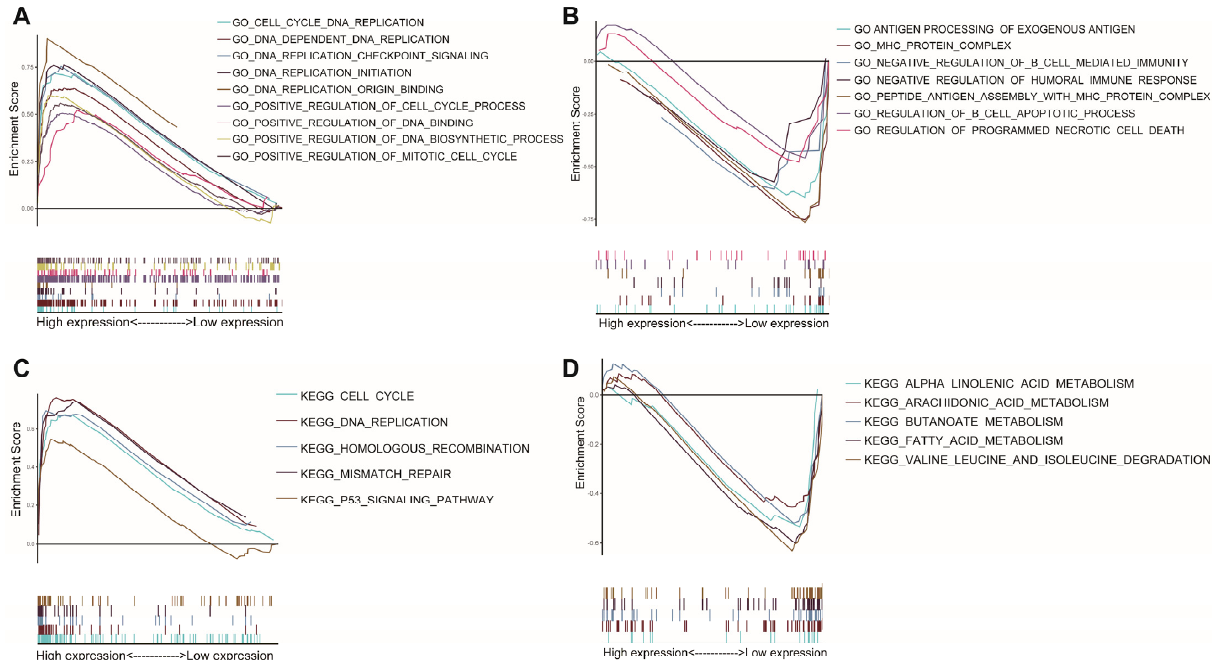
Figure 6. Gene set enrichment analysis between the two AAMRGS subgroups based on the AAMRGS. GO enrichment in the AAMRGS-high group ( A ) and AAMRGS-low group ( B ). KEGG enrichment in the AAMRGS-high group ( C ) and AAMRGS-low group ( D ).